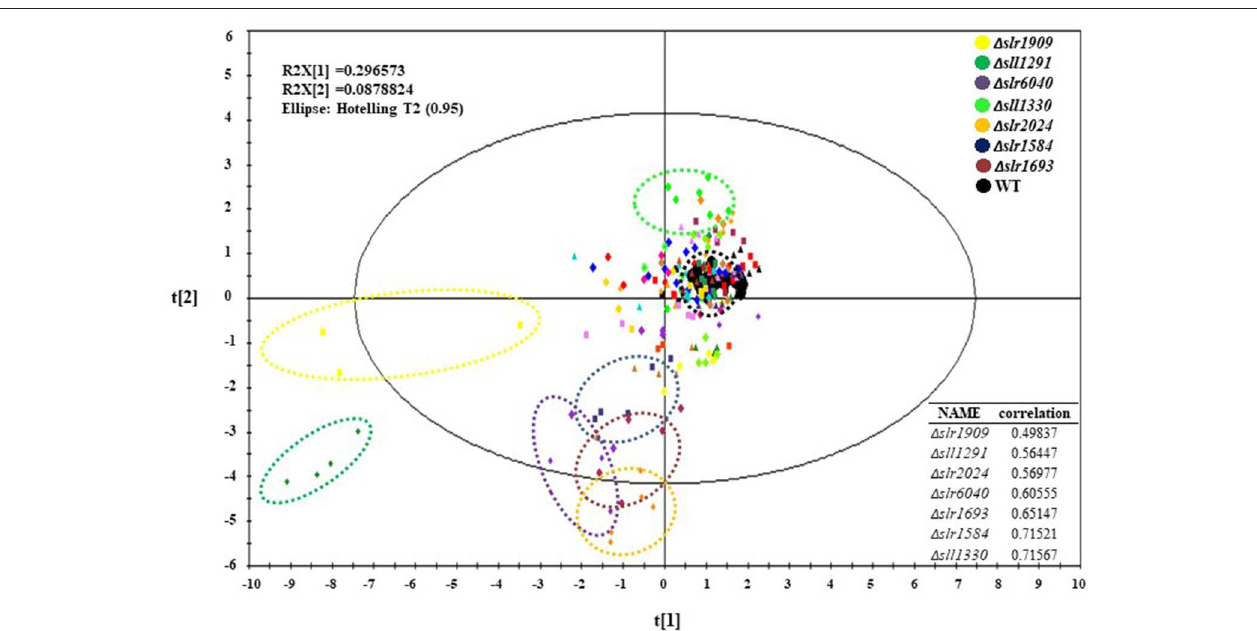
FIGURE 2 | PCA plots of the GC-MS metabolomic profiles at 48h. Different mutants were represented by different